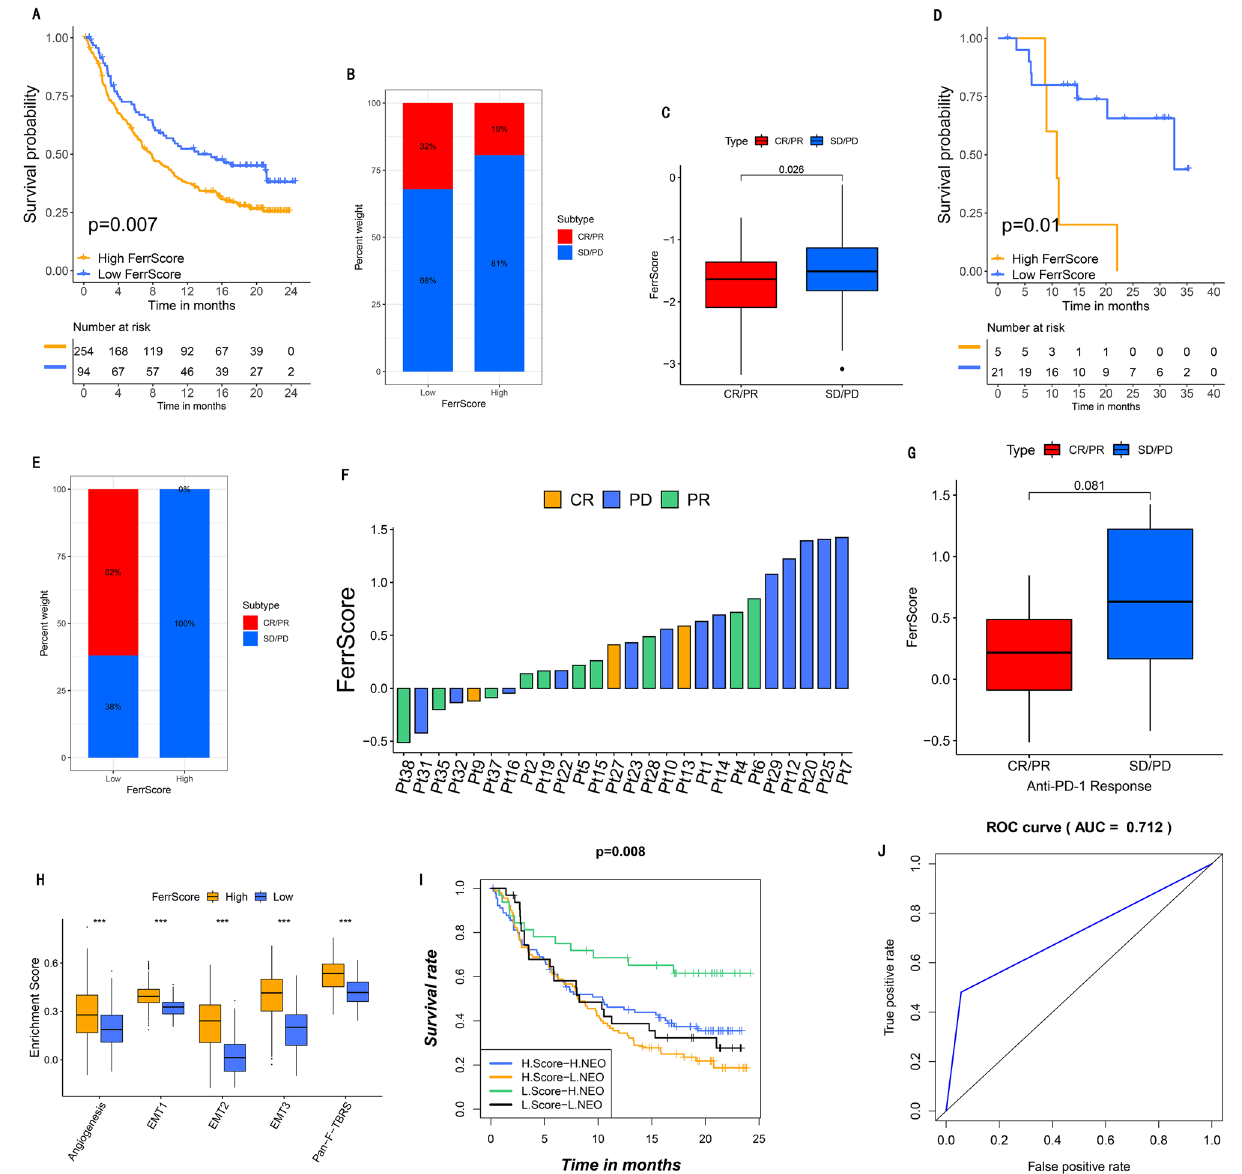
Figure 6. The role ferroptosis subtypes playing in anti-PD-L1/1 immunotherapy. ( A ) Survival analysis performed with Kaplan–Meier curves between low (94 patients) and high (254 patients) FerrScore groups in the anti-PD-L1 immunotherapy dataset (IMvigor210 dataset; p = 0.004, Log-rank test). ( B ) The effective rate of the high or low FerrScore patients receiving PD-L1 blockade immunotherapy. SD means stable disease; PD means progressive disease; CR means complete response; and PS means partial response. ( C ) FerrScore in two distinct anti-PD-L1 immunotherapy outcome groups. ( D ) Survival analysis performed with Kaplan–Meier curves between low and high FerrScore patient receiving anti-PD1 immunotherapy (GSE78220 dataset; p = 0.01, Log- rank test). ( E ) The effective ratio in low and high FerrScore patients receiving PD-1 blockade immunotherapy. ( F ) Correlative analysis between FerrScore and treatment effect of anti-PD-1 immunotherapy. Pt means patients, PD was shown in blue color, PR was shown in green color and CR was shown in yellow color. ( G ) FerrScore in two different anti-PD-1 immunotherapy outcome groups. ( H ) Diversities in stroma activated pathways between low and high FerrScore groups in patients receiving anti-PD-L1 immunotherapy (*** p less than 0.001). ( I ) Survival analysis performed with Kaplan–Meier curves for in anti-PD-L1 immunotherapy dataset classified with both neoantigen burden and FerrScore. H: high; L: low; NEO: neoantigen burden ( p = 0.008, Log-rank test). ( J ) The predict value of FerrScore in patients receiving anti-PD-L1/1 treatment (AUC,